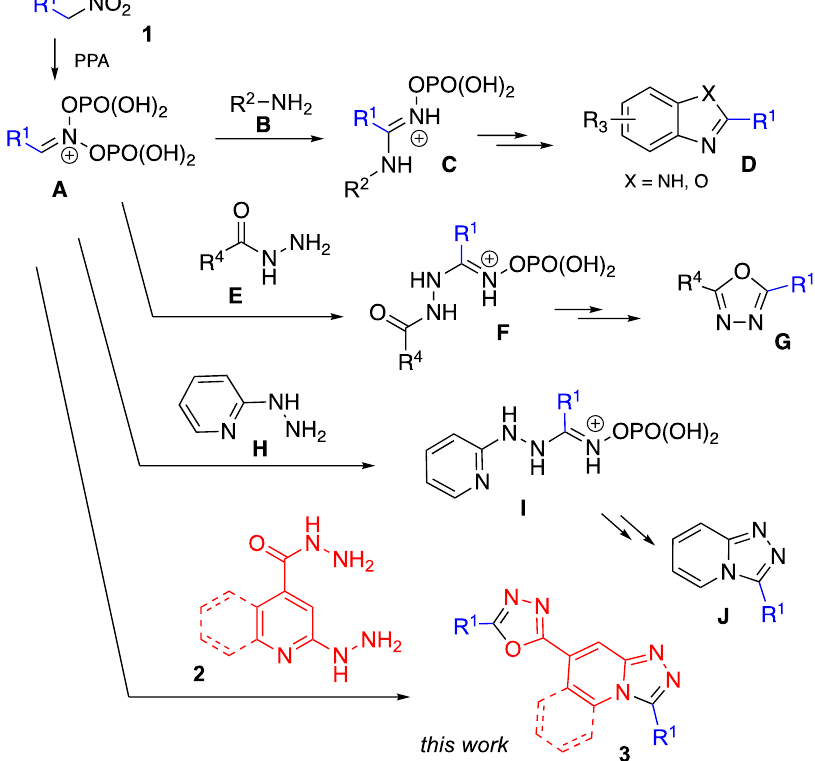
Table 1. Optimization of the reaction conditions for a one-pot double-annulation toward a chi- meric product 3aa